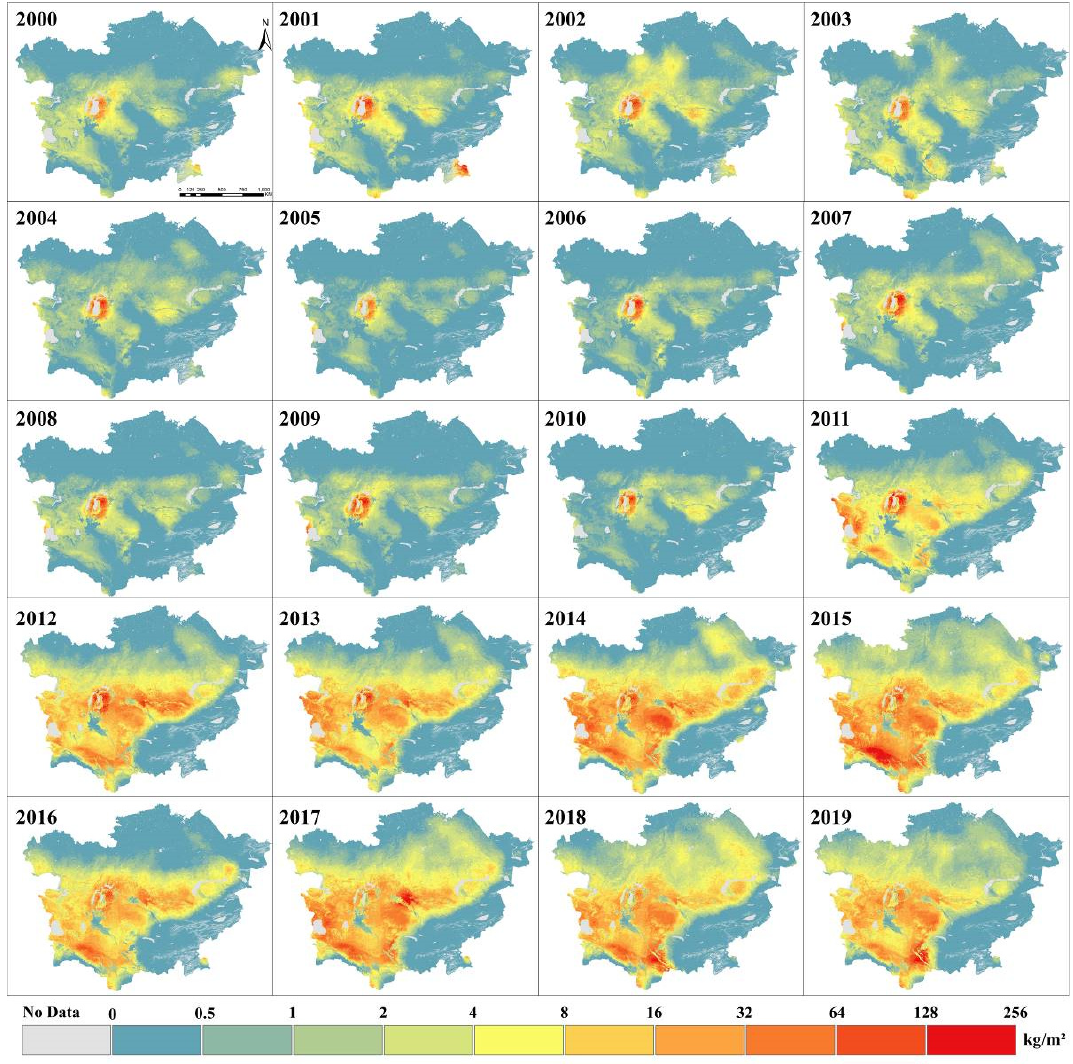
Figure 5. The spatial variation of the Soil Wind Erosion Potential (SWEP) over CA between 2000 and 2019.